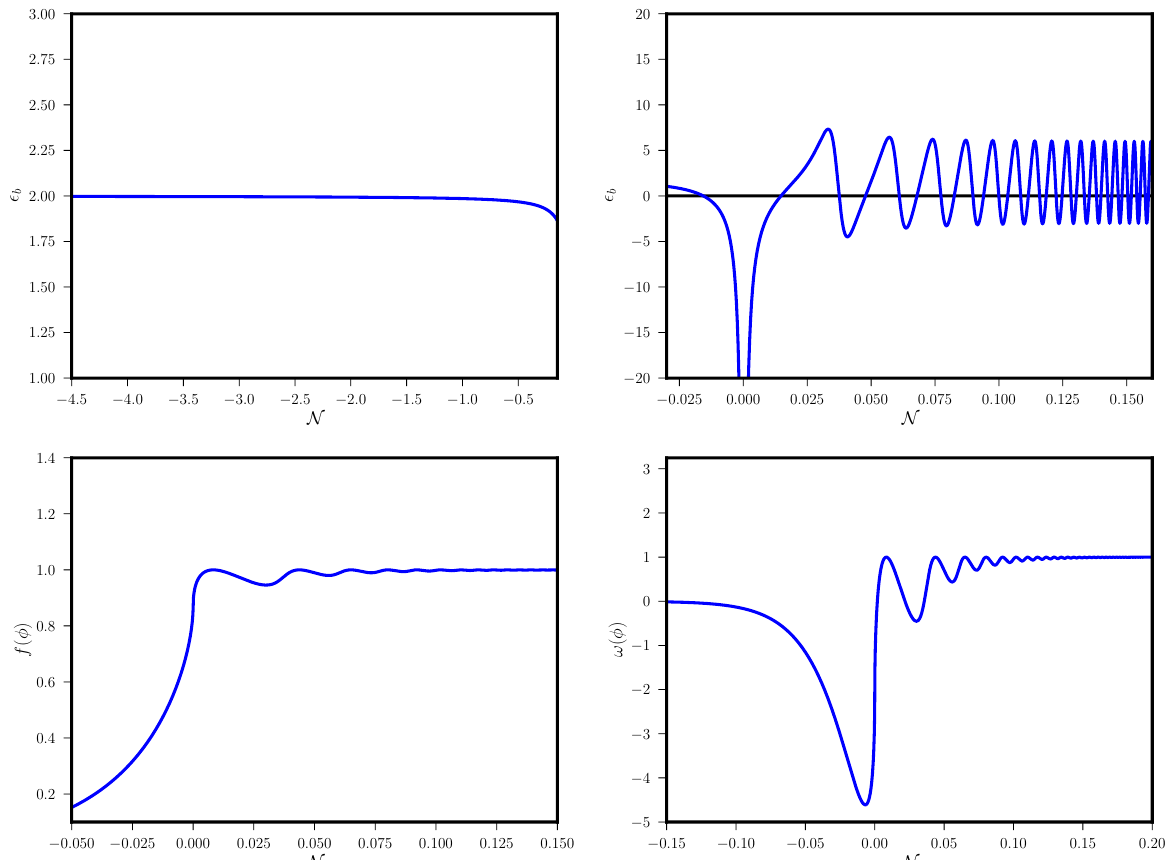
Figure 1. The slow-roll parameter in the contracting region ( top-left ), the slow-roll parameter in the bouncing region ( top-right ), the coupling function ( bottom-left ), and ω ( φ ) ( bottom-right ) in the non-minimal theory (4) are plotted for the chaotic bouncing model with α = 1 with respect to the e-N-fold time convention is negative, whereas, at bounce, it becomes zero and then during expansion, it becomes positive). It is apparent that, N during the contraction period, the scale factor behaves as a ( η ) ∝ ( solution is asymmetrical. The coupling function f ( φ ) as well as ω ( φ ) become nearly unity in the reheating epoch, which arises shortly after the